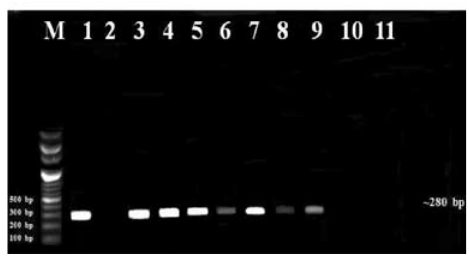
Fig. 1. Agarose gel electrophoresis of Mycoplasma genus specific PCR products